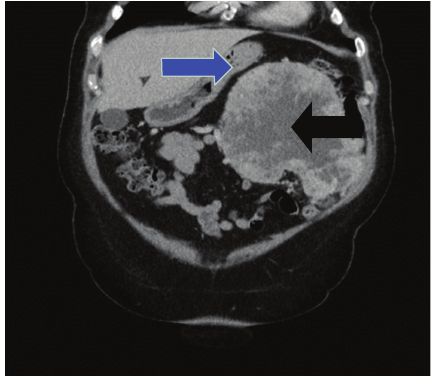
Figure 4: Computerised tomography (CT) scan of abdomen showing the renal mass (black arrow) close to the stomach (blue